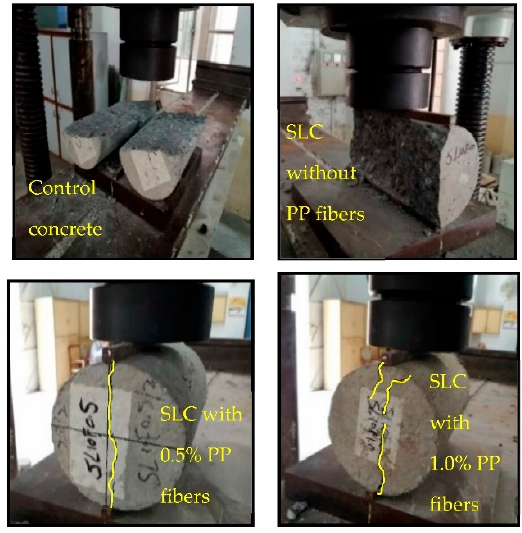
Figure 10. Failure behavior in split tensile strength test.